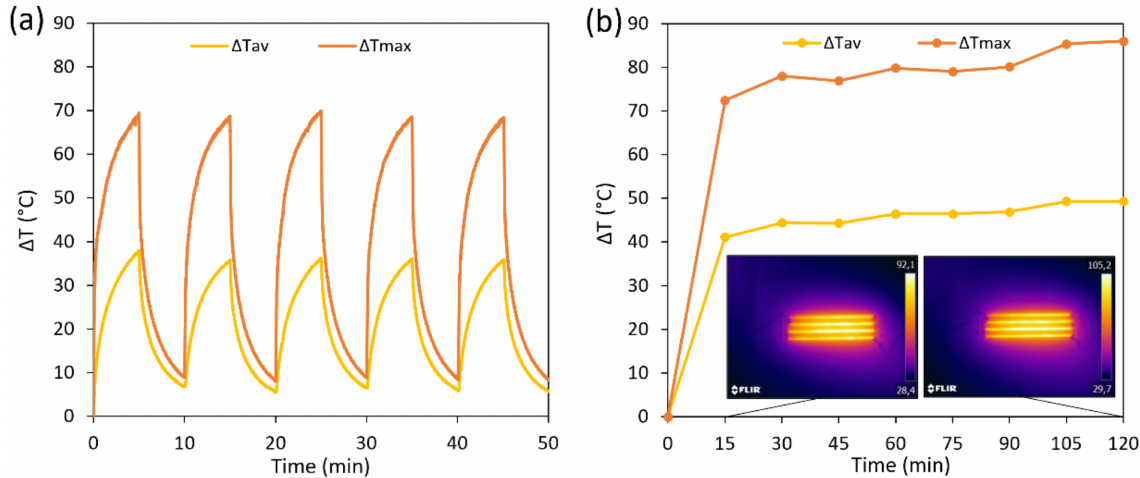
Figure 8. ( a ) Cyclic self-heating test and ( b ) continuous self-heating test carried out for 2